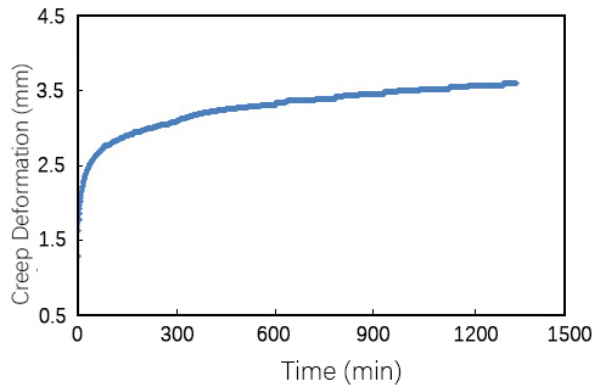
Figure 4. Creep-deformation diagram.